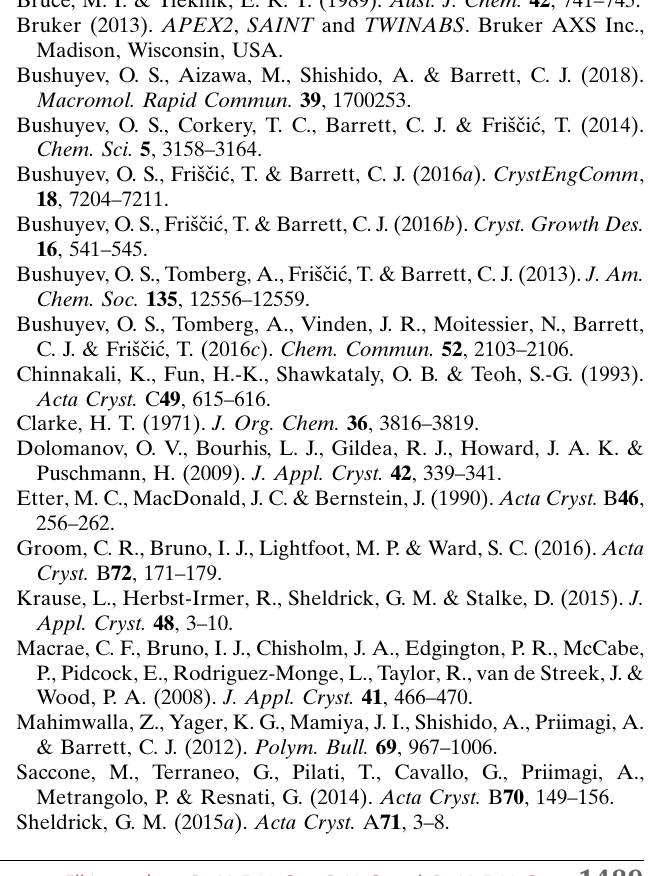
Crystal data Chemical